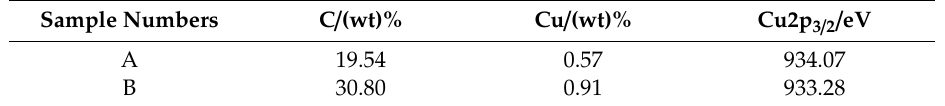
Table 4. Electron binding energy and relative content of major elements on the surface of the sample.